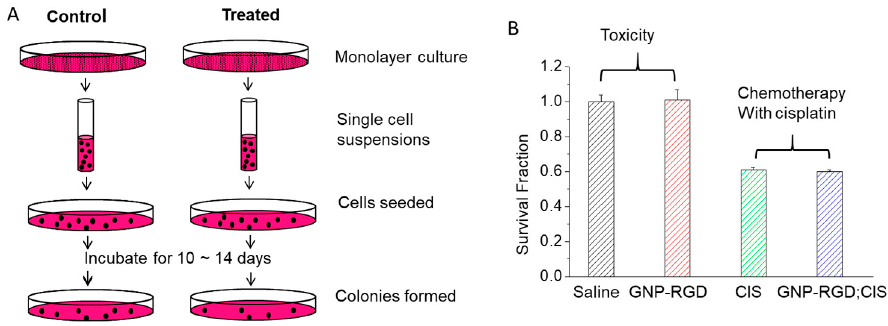
Figure 3. ( A ) Steps used in the clonogenic assay; ( B ) Toxicity and effect of cisplatin action in the absence and presence of GNPs. Data are means ± S.D. for n = 9 cell preparations over three independent experimental set-ups.